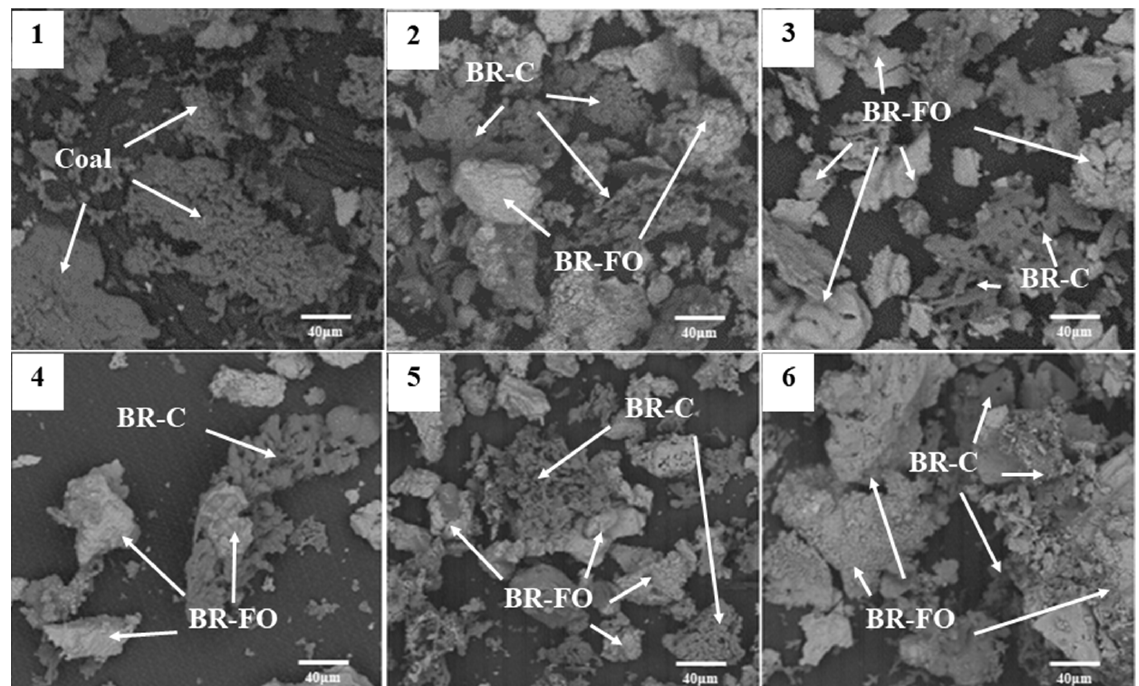
Figure 9. SEM images of pulverized coal combustion residues with different iron-containing pure mineral additions. BR-C: pulverized coal combustion residues; BR-FO: iron-containing pure mineral roasting residues. 1 —pulverized coal; 2 —pulverized coal and hematite; 3 —pulverized coal and magnetite; 4 —pulverized coal and specularite; 5 —pulverized coal and siderite; 6 —Pulverized coal and limonite.